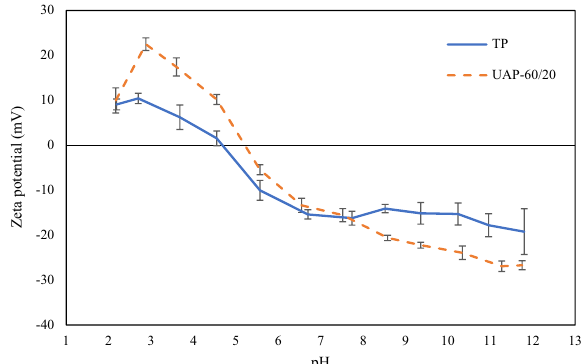
Figure 3. Zeta (ζ)-potential of protein extracted from Bombay locust by selected ultrasound-assisted process at 60% amplitude for 20 min (UAP-60/20) and typical extraction process (TP) at different pH values. Bars represent the standard deviation (n =